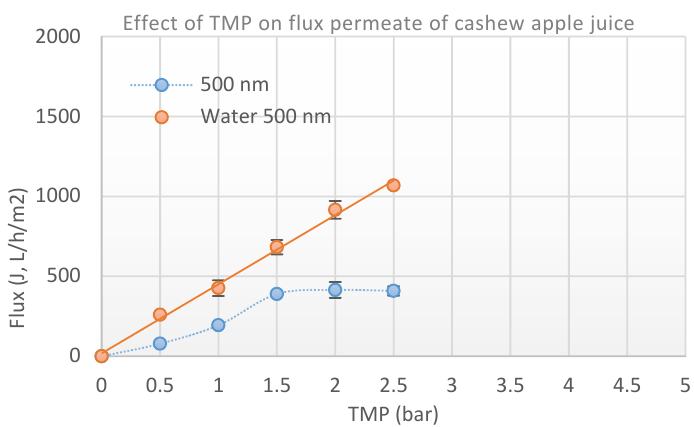
Figure 6. Effect of TMP on flux permeate of cashew apple juice ( T = 30 °C; membrane = 500 nm).